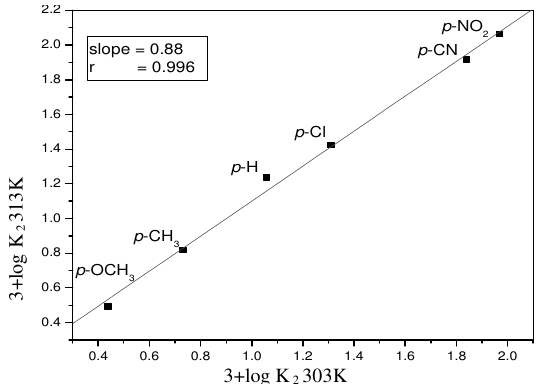
Figure 3 . Exner plot between log k